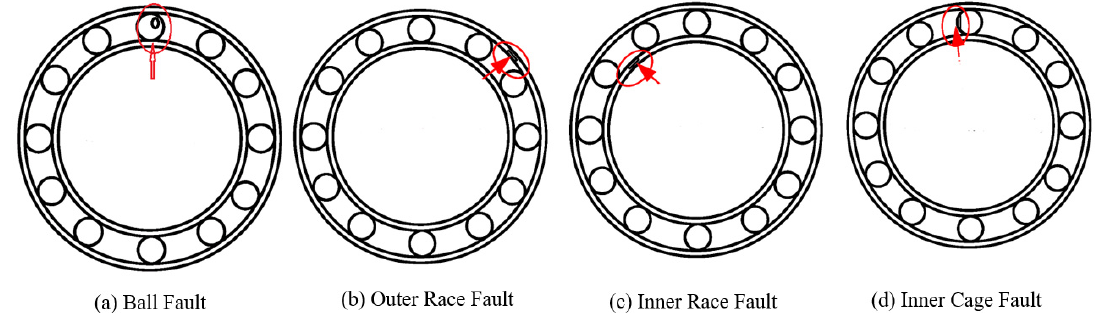
Figure 3. Typical bearing faults. Table 1. Data generation plan.